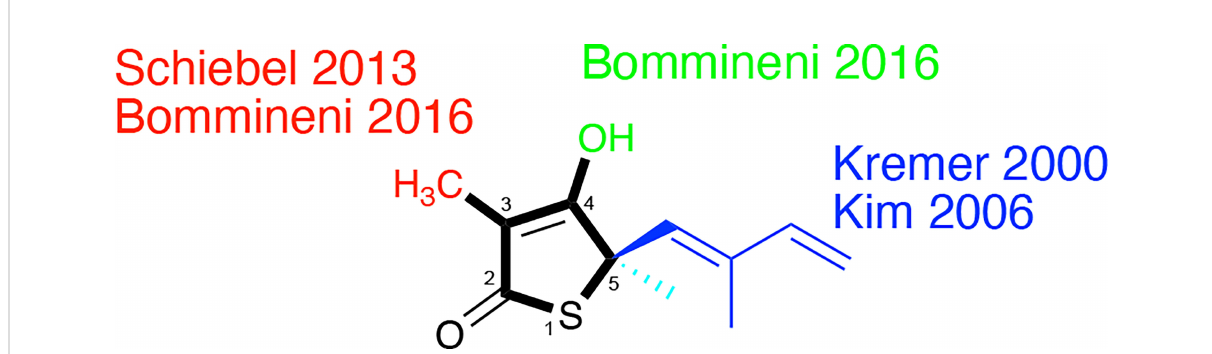
FIGURE 5 Thiolactomycin and its analogs. Noted are efforts, referenced within, regarding analogs at the speci fi c positions of the thiophen-2(5H)-one ring system which are